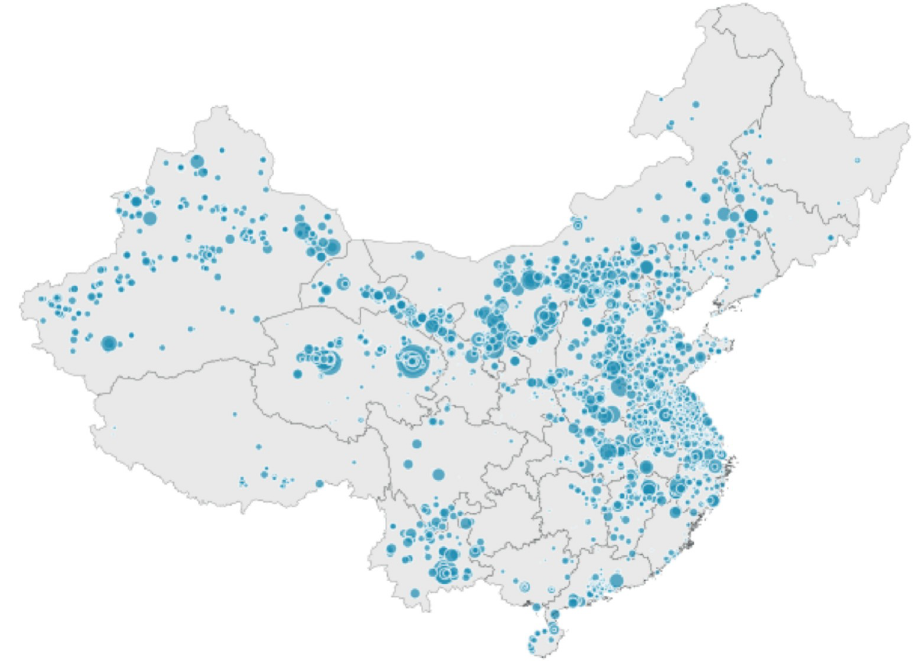
Fig 3. Distribution of the grid-connected solar PV plants scaled by capacity. Data from Bloomberg NEF [11] under a CC BY license, with permission from [11].